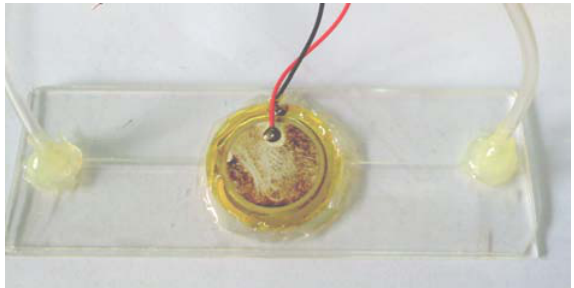
Figure 9. Drawing of the NMPV micro-pump system.